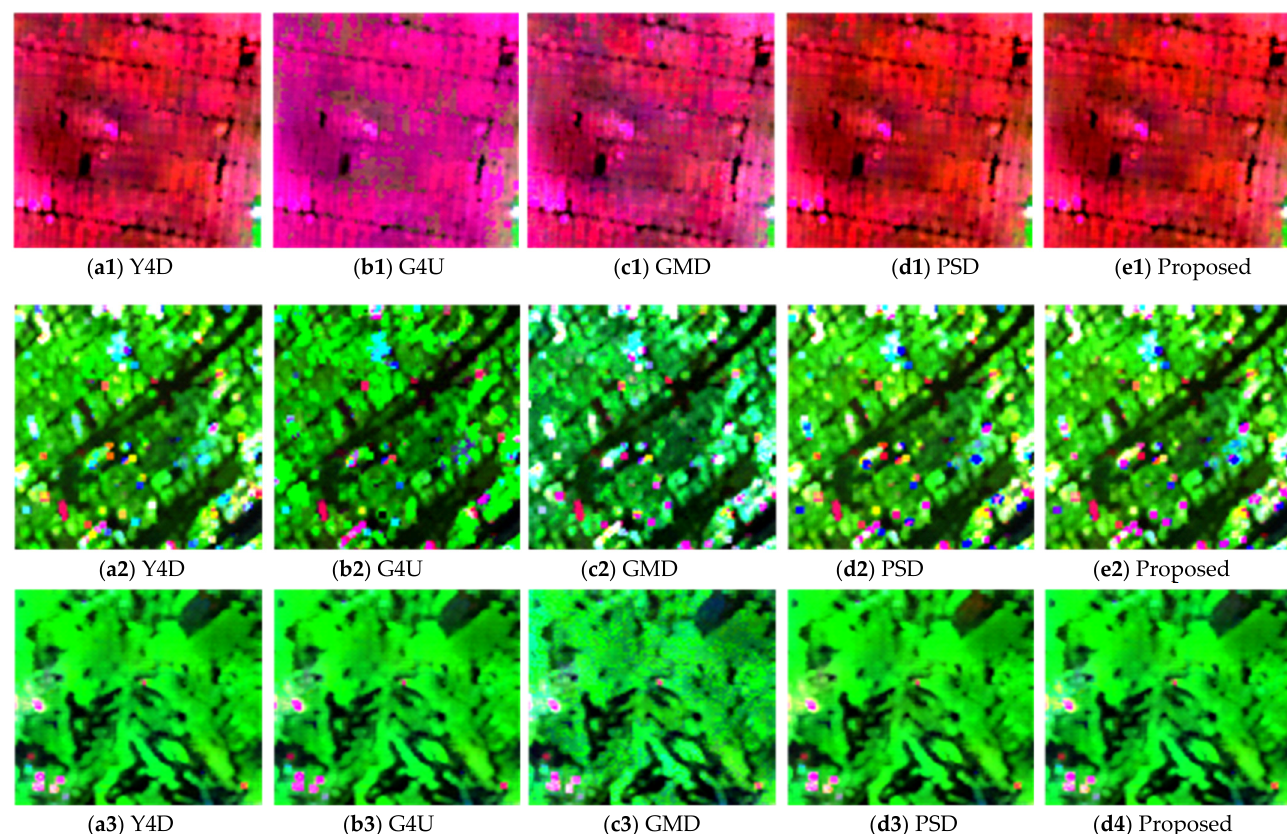
Figure 8. Decomposition results of ALOS-2 data. ( a , b ) are the optical and Pauli image. ( c – g ) are the decomposition result of different decomposition methods. The images are colored by Pd (red), Pv (green), and Ps (blue).